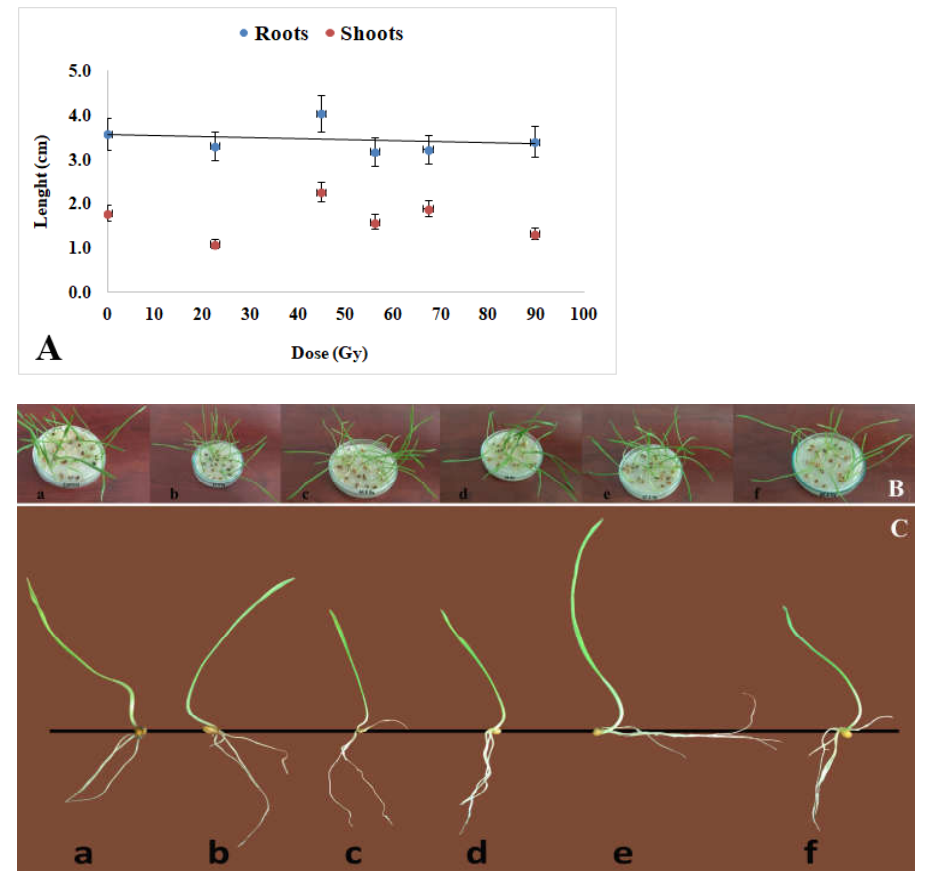
Figure 3. ( A ). Roots and shoots in the seedlings grown from the seeds exposed to a proton beam at the Bragg peak showed only slight variations, in the limits of standard deviation, with no distinct correlation with the applied radiation dose. Twenty seedlings for each experimental variant were measured. ( B ). General aspect of wheat seedlings (7 days old) grown in Petri dishes after proton treatment (a-Control; b-22.4 Gy; c-44.8 Gy; d-56 Gy; e-67.2 GY, f-89.6 Gy). ( C ). Wheat seedling morphology in each sample after 7 days of germination (a-Control; b-22.4 Gy; c-44.8 Gy; d-56 Gy; e-67.2 GY, f-89.6 Gy). Each dish hosted 25 seedlings and for each experimental variant, three repetitions were conducted.